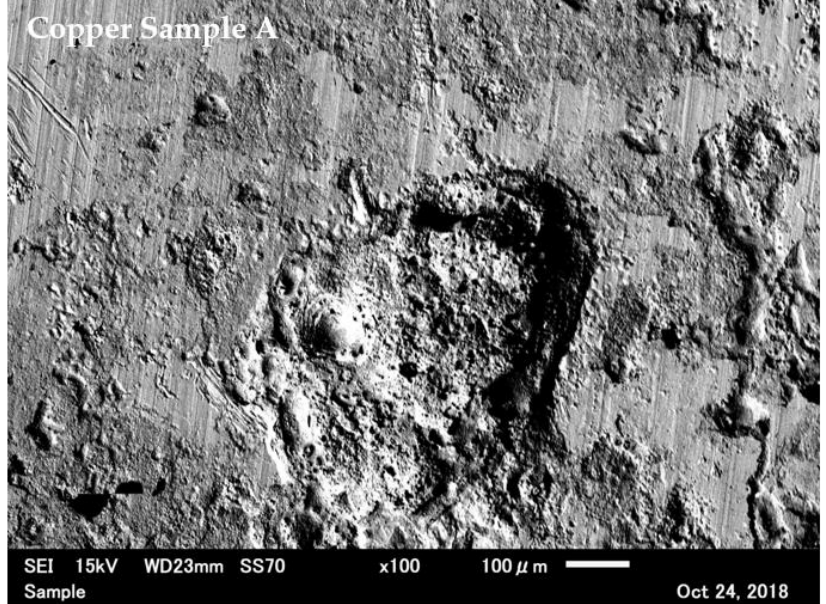
Figure 12. The same copper contact surface after it was subjected to an electrical arc of 4 A. The sample was treated with HCl to remove oxides on the surface. The sample is viewed under an electron microscope at 100 × magnification.